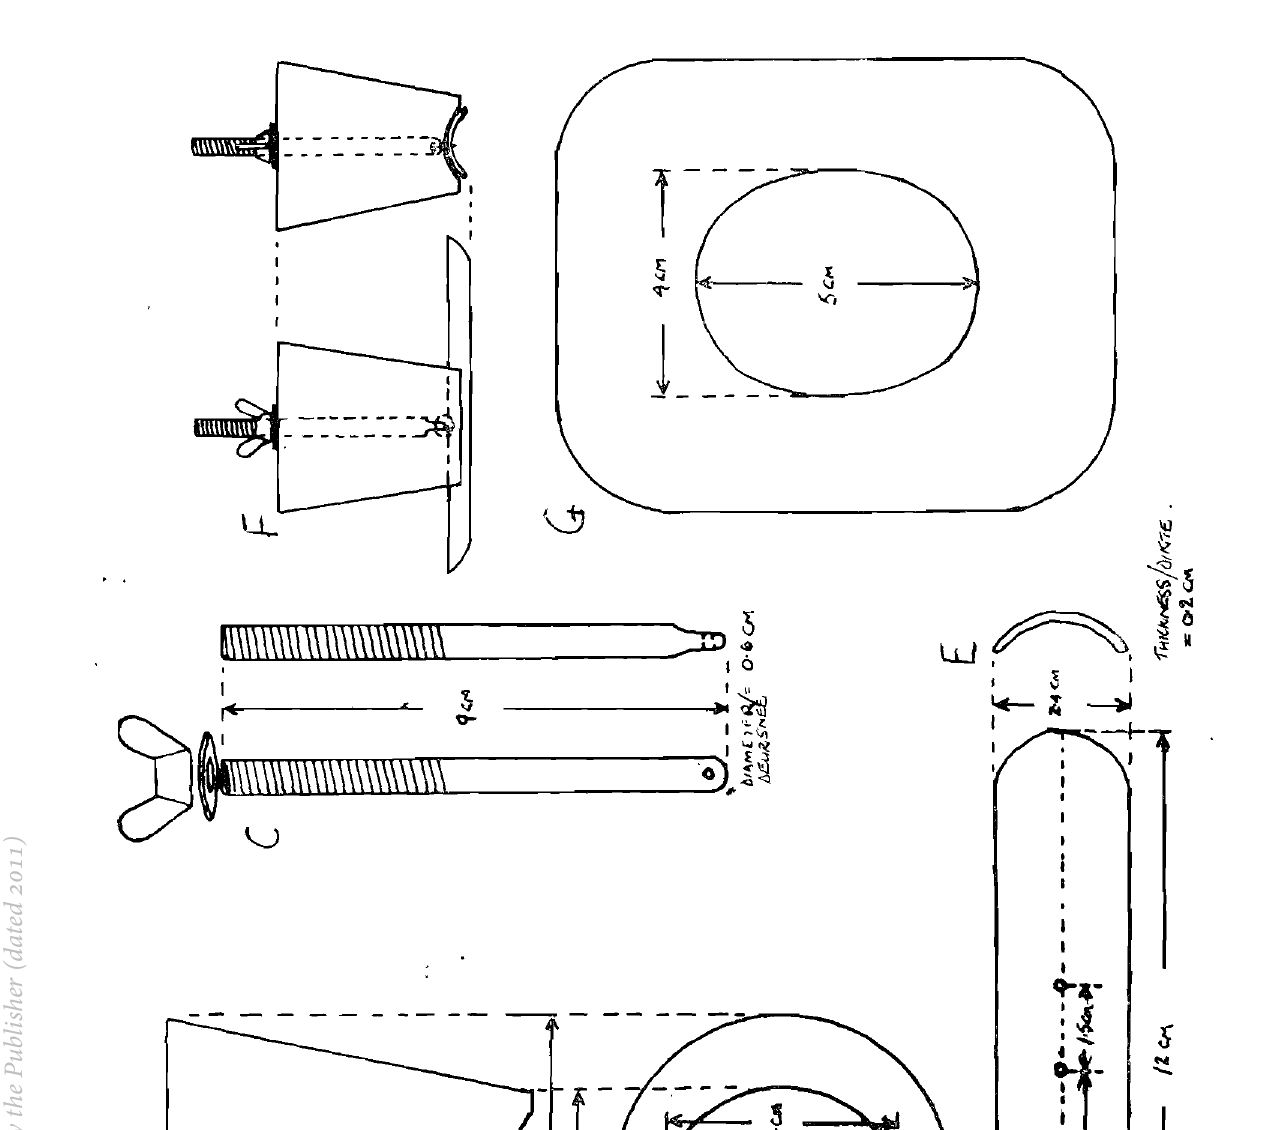
FIG. 1. Equipment for the oesophageal fistulating of cattle. A. Plug-side